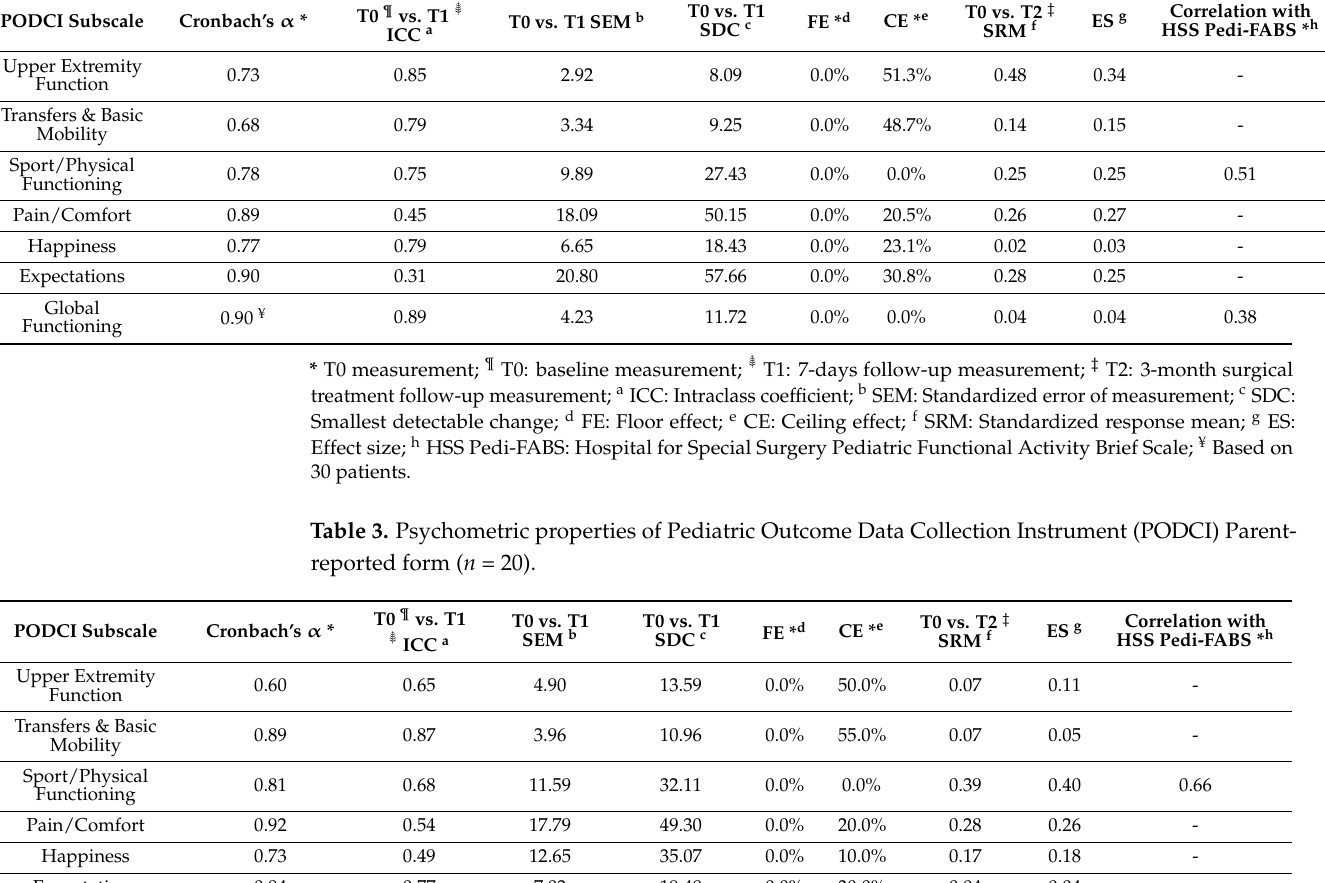
Table 2. Psychometric properties of Pediatric Outcome Data Collection Instrument (PODCI) Adoles- cent self-reported form ( n = 39). Table 1. Patient demographics and clinical characteristics.